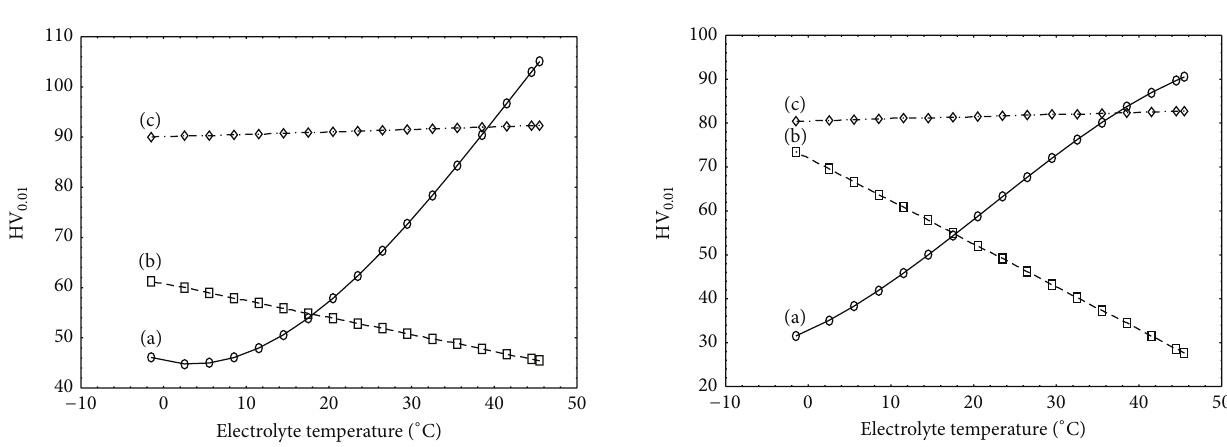
Figure 8: The dependence of the layer microhardness on the tem- perature of the electrolyte: c (H 2 SO 4 ) = 1.43mol ⋅ L −1 , c (C 2 H 2 O 4 ) = 0.06 mol ⋅ L −1 , U = 10V, t = 25min. (a) 1A ⋅ dm −2 , (b) 3 A ⋅ dm −2 , and (c) 5 A ⋅ dm −2 .